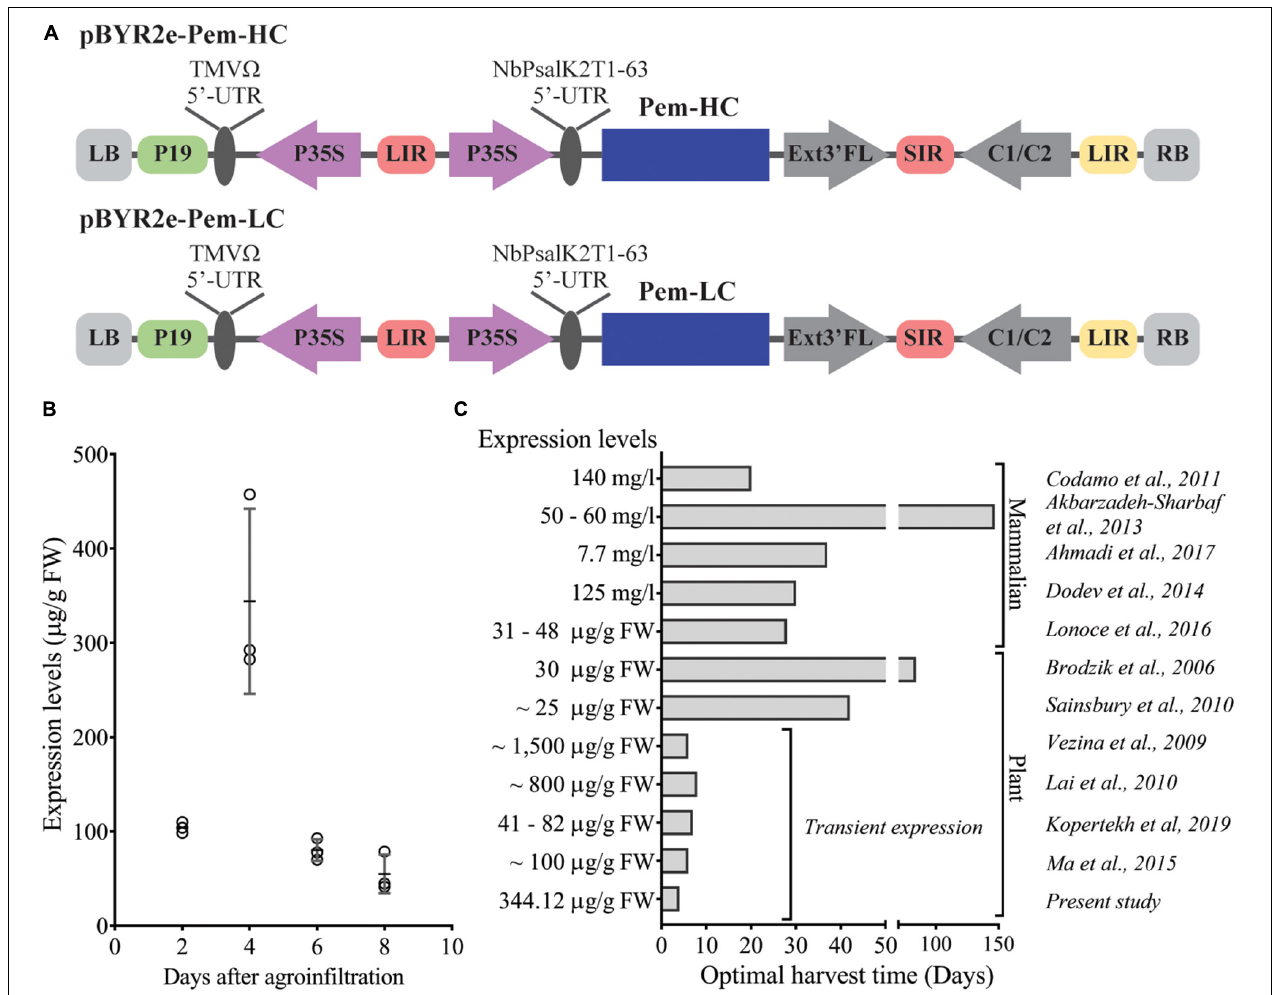
FIGURE 1 | Rapid transient expression of Pembrolizumab in N. benthamiana . (A) Schematic representation of the T-DNA regions of the expression vectors used for the transient expression of Pembrolizumab in N. benthamiana . P19: the RNA silencing suppressor gene derived from tobacco bushy stunt virus (TBSV); P35S: Cauliflower Mosaic Virus (CaMV) 35S promoter; TMV (cid:127) 5 (cid:48) -UTR: 5 (cid:48) untranslated region (UTR) of tobacco mosaic virus (cid:127) ; NbPsalK2T1-63 5 (cid:48) UTR: 5 (cid:48) UTR of Nicotiana photosystem I reaction center subunit psaK ; Pem-HC: heavy chain of Pembrolizumab; Pem-LC: light chain of Pembrolizumab; Ext3 (cid:48) FL: 3 (cid:48) region of tobacco extension gene; C1/C2: Bean Yellow Dwarf Virus (BeYDV) ORFs C1 and C2 encoding for replication initiation protein (Rep) and RepA; SIR and LIR: short and long intergenic regions of the BeYDV genome; LB and RB: left and right borders of the Agrobacterium T-DNA region. (B) The antibody expression levels in wild-type N. benthamiana on day 2, 4, 6, and 8 after agroinfiltration were quantified by ELISA. Data are presented as mean ± SD. (C) Comparison between the optimal harvest time and the recombinant antibody expression levels with previous reports. Cost comparison of these mAbs production in plants and mammalian system was not